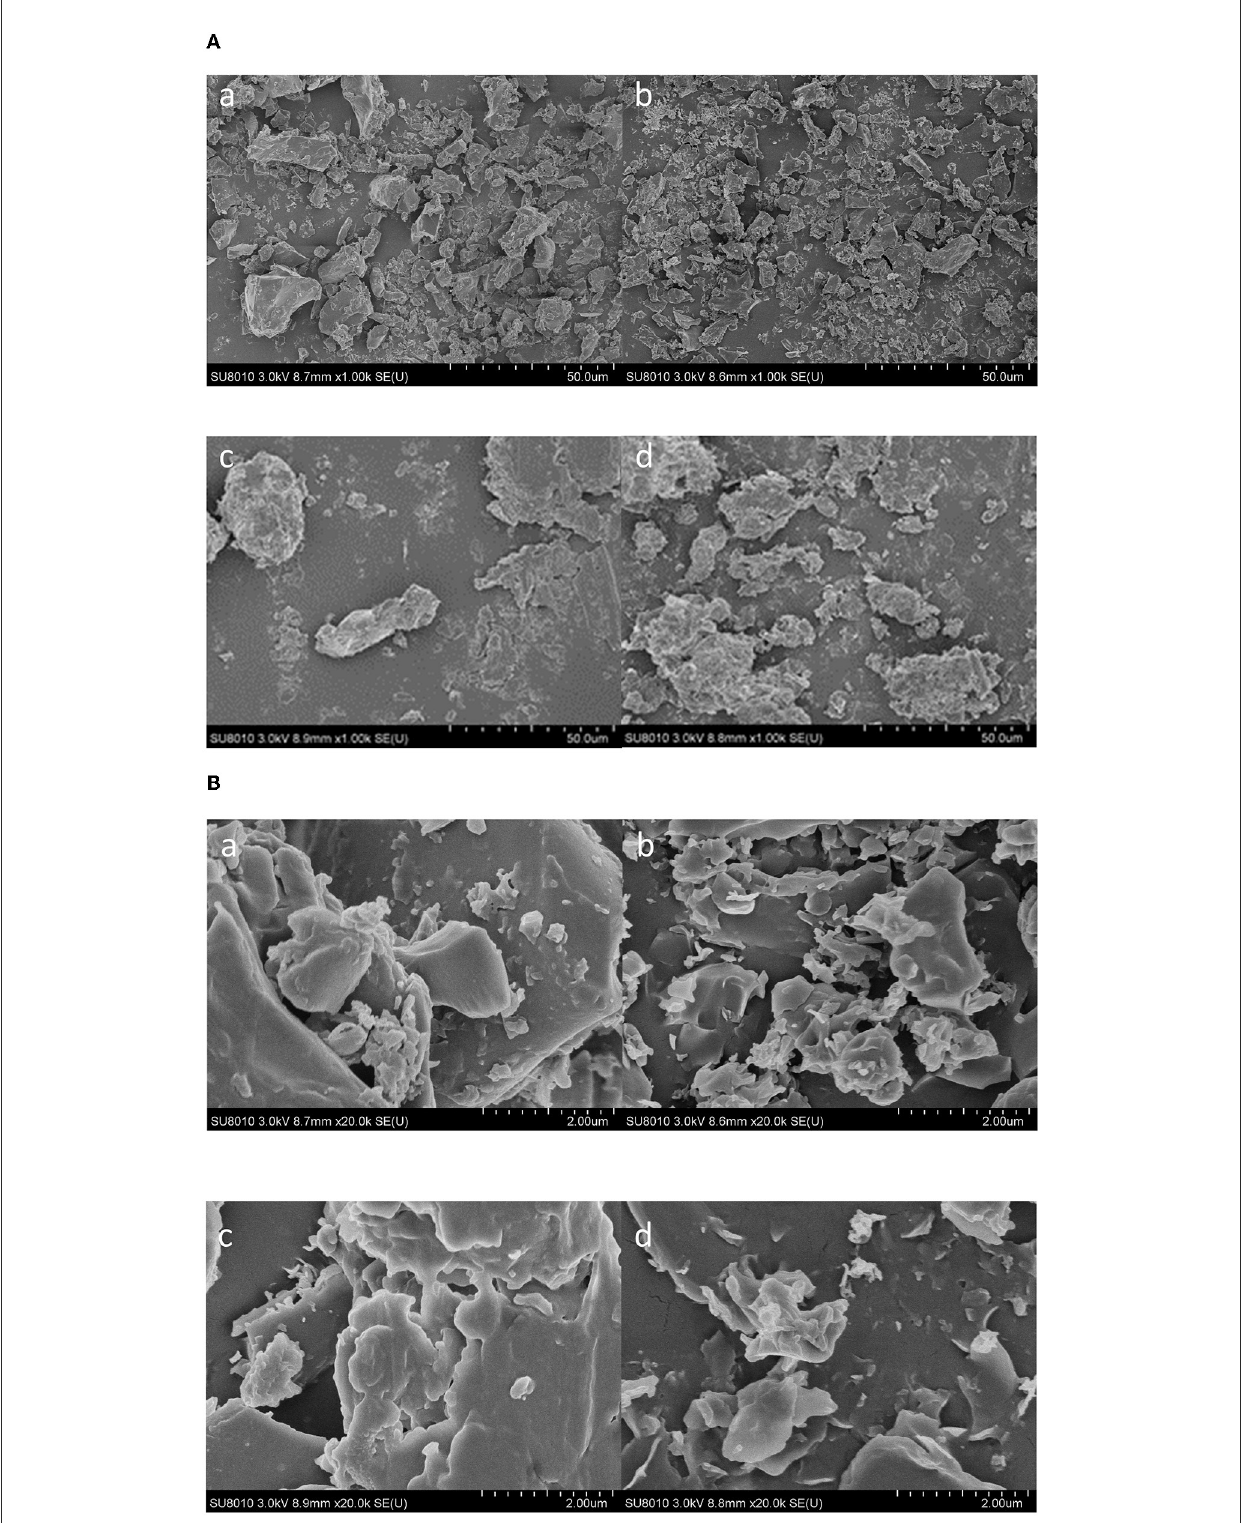
FIGURE8 Scanning electron microscopy graphs of maceration extract (a), ultrasound extract (b), and propolis residues from maceration extraction (c) and ultrasound extraction (d) with the magnification of 1000 × (A) and 20000 × (B) .